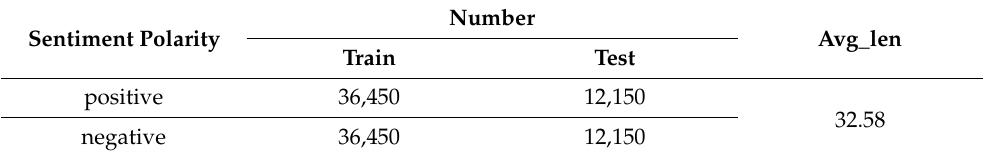
Table 1. General statistics of Chinese review dataset.